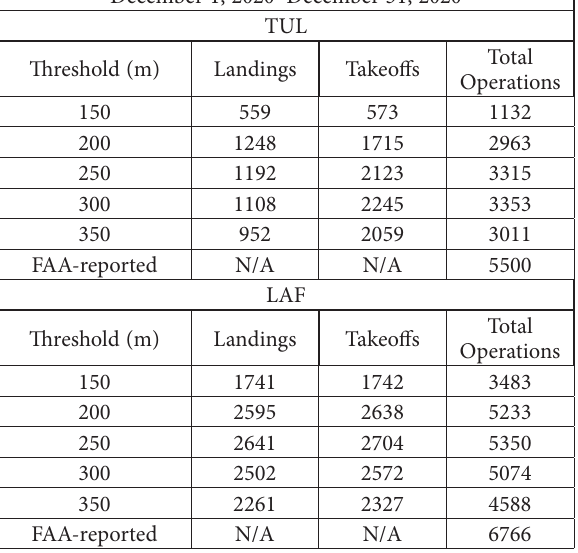
Table 1. The number of detected landings and takeoffs changes based on the selected threshold. The maximum landings and maximum takeoffs are not detected at the same threshold altitude. Note that the control tower at LAF does not operate overnight, but the algorithm continued to detect